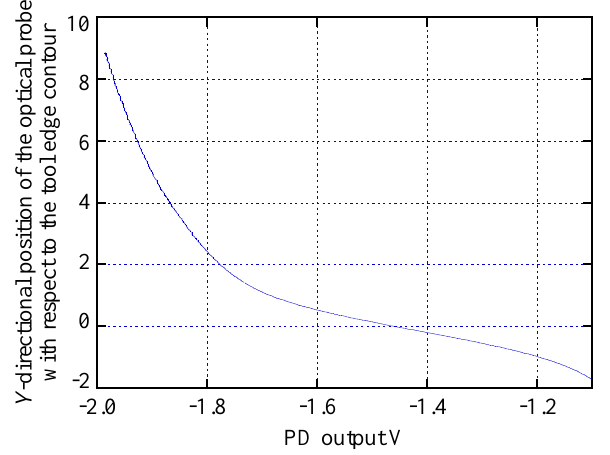
Figure 11. Relationship between the PD output and the y - directional relative position of the optical probe with respect to the round cutting edge (nose radius: 0.9mm).